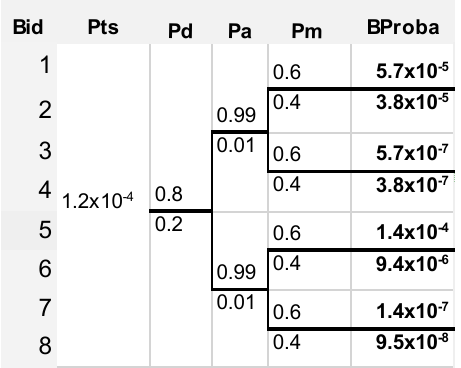
Figure 13. Event tree for the intrusion of an unauthorized drone in LIMC 17 departure path (<1 km from runway) when take-off is occurring.